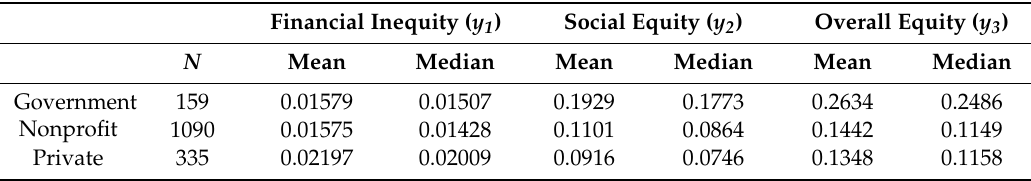
Table 3. Distribution of equity indicators across three sectors.